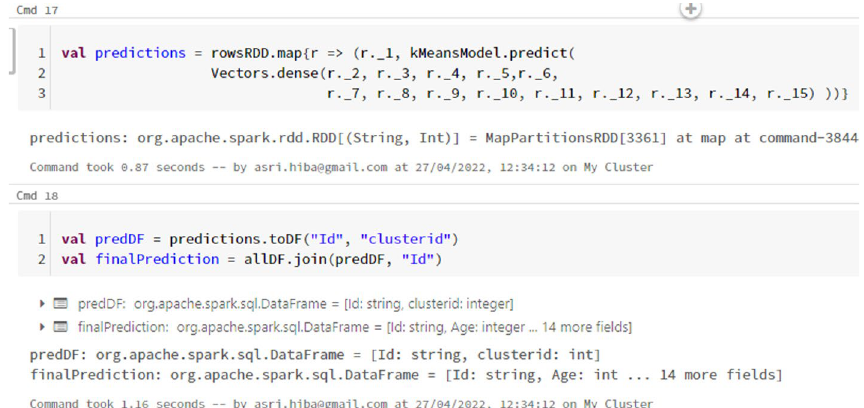
Fig. 6 Prediction of clusters using Kmeans